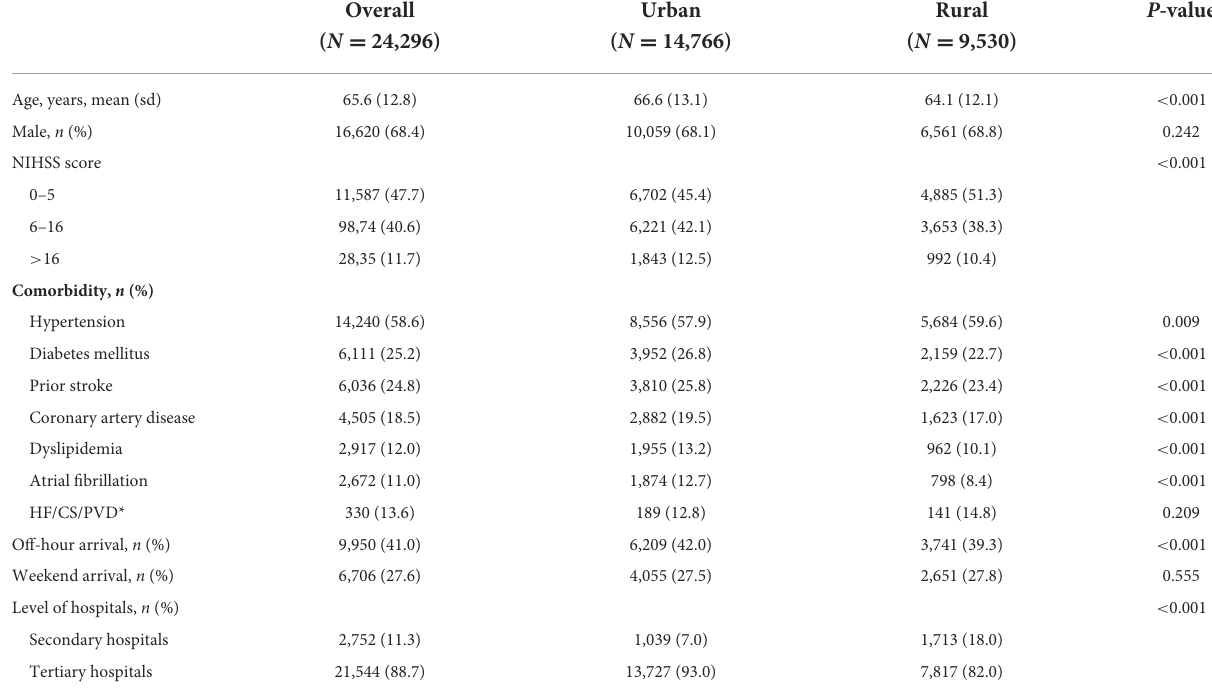
TABLE 1 Characteristics of AIS